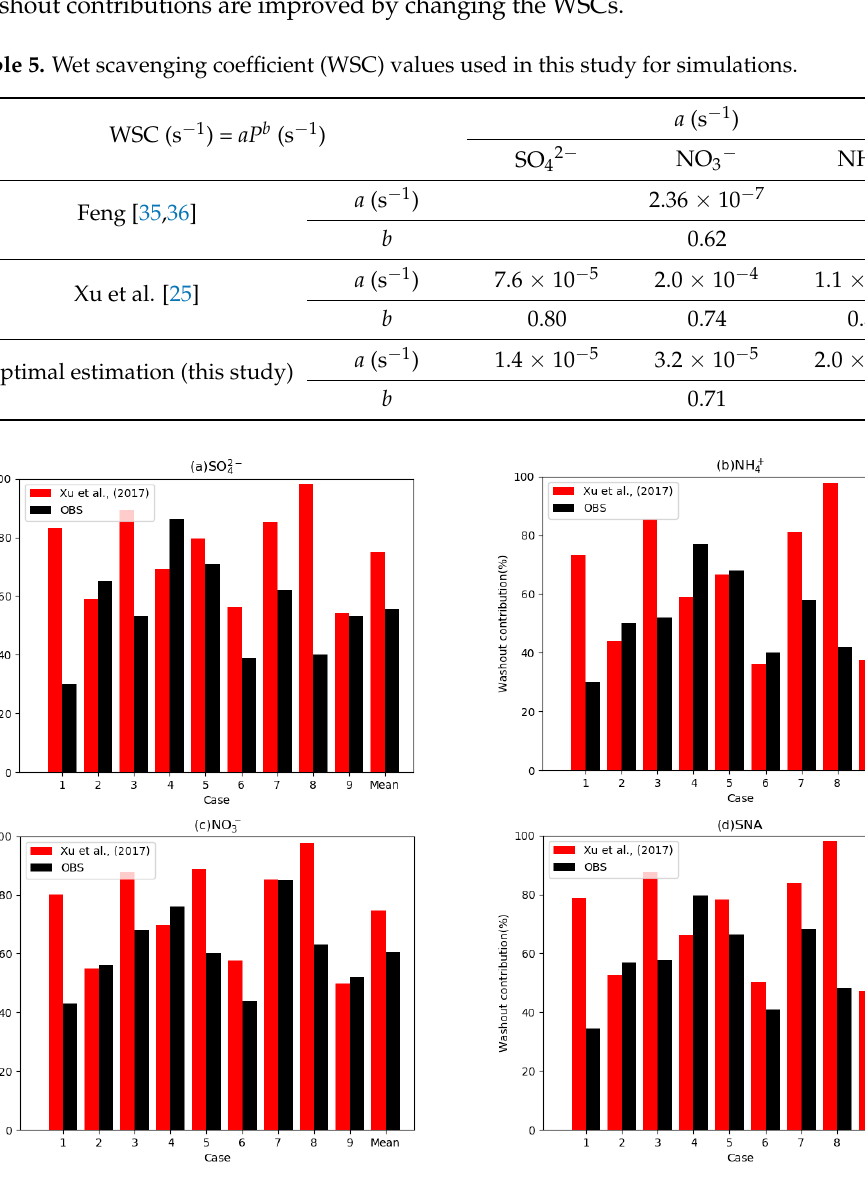
Figure 4. Observed washout contributions (%) from the total wet deposition flux for the nine cases observed by Xu et al. [25] (black bars) and simulated washout contributions (%) with the wet scavenging coefficients suggested by Xu et al. [25] (red bars). Each figure denotes ( a ) the washout contributions of SO 42 − , ( b ) NH 4+ , ( c ) NO 3 − , and ( d ) the average of the three species. Table 5. Wet scavenging coefficient (WSC) values used in this study for simulations.